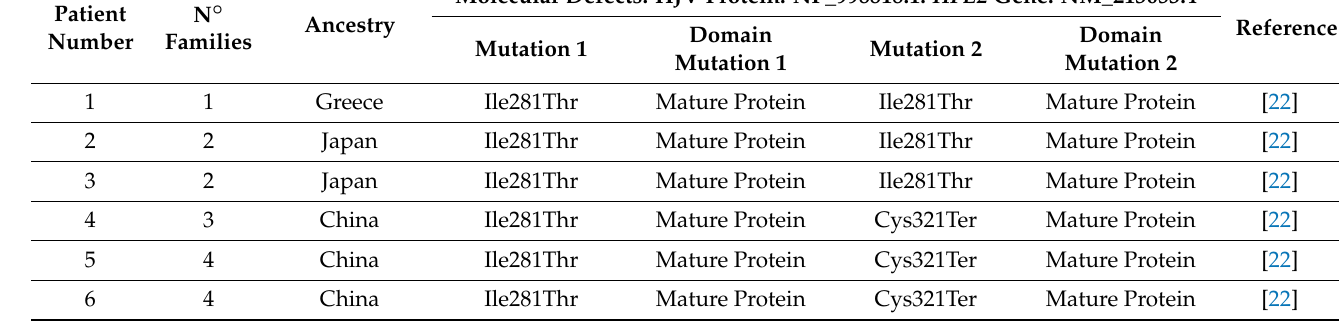
Table A1. List of patients diagnosed with non-HFE related HH with mutations in the HFE2 gene. The domain localiza- tion of the mutations is described according to the Figure 2